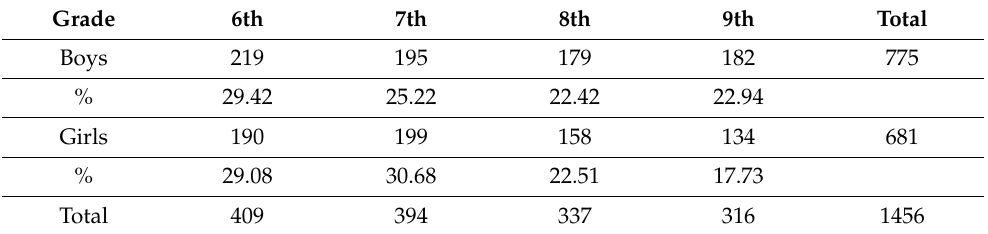
Table 1. Distribution of boys and girls in the group according to the school